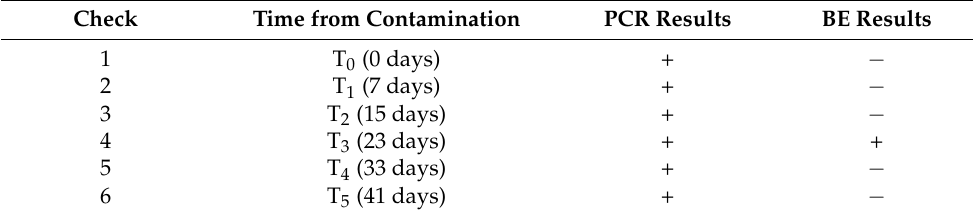
Table 3. Results of the tests related to the first experimental batch.